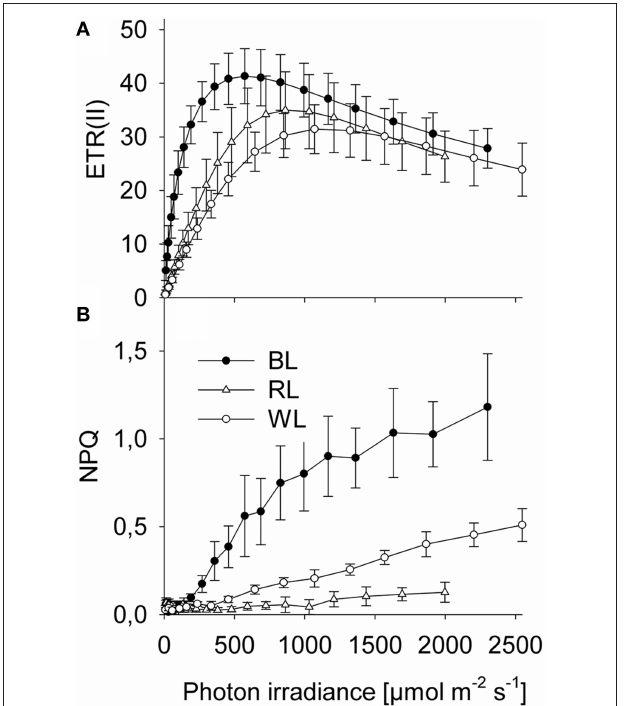
Single Cell Variable Chlorophyll Cells with altered chloroplast distribution exhibited a significant decrease in Y(II), independently from whether cells were treated with high levels of blue light (600 µ mol m − 2 s − 1 BL) for 1 h, or if they were kept in the dark [ F (1 , 19) = 727.167; p < 0.001; Figure 5A ]. In untreated cells, Y(II) decreased from 0.44 ± 0.02 in cells with evenly distributed chloroplasts to 0.00 ± 0.01 in cells with altered chloroplast distribution ( p < 0.001; compare Figure 6 ). After BL exposure, Y(II) decreased from 0.35 ± 0.03 in cells with evenly distributed chloroplasts to 0.00 ± 0.08 in cells with altered chloroplast distribution ( p < 0.001). Recovery